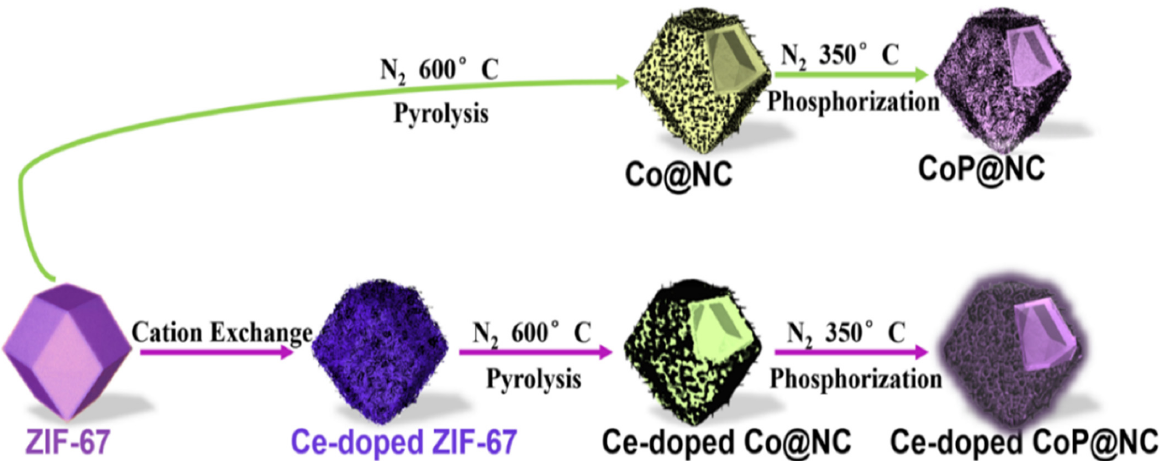
Figure 1. Schematic illustration showing the growth process of CoP@NC and Ce-doped CoP@NC hollow polyhedron.